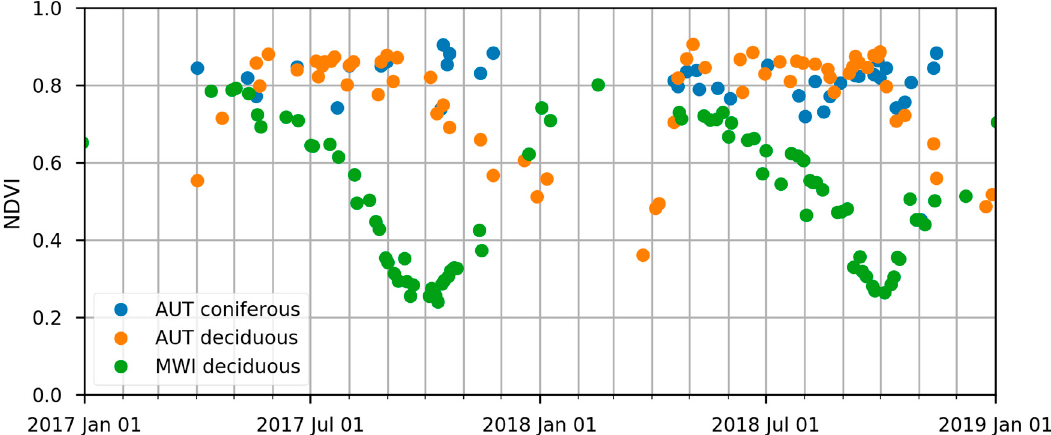
Figure 2. Typical temporal NDVI (Normalized Difference Vegetation Index) signatures over two years for single pixels corresponding to specific forest types and test sites. Larger data gaps occur in the winter months due to snow cover in Austria (AUT) or the rainy season in Malawi (MWI). Outside of these periods, the observation density is high enough to capture the seasonal patterns.